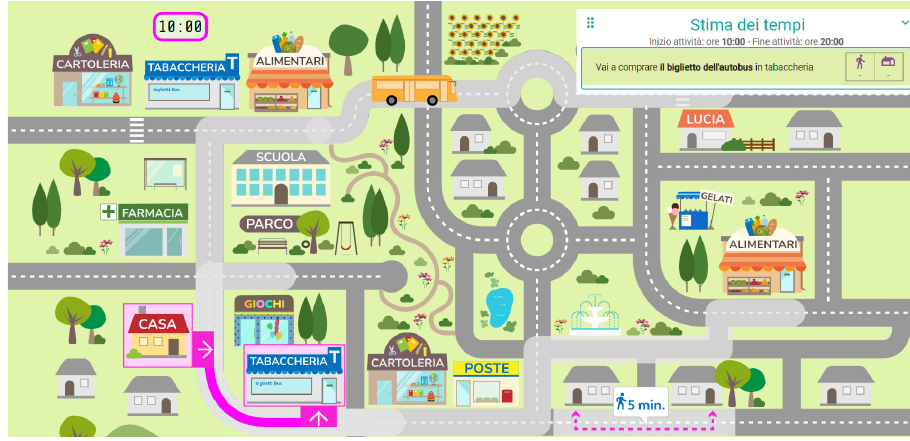
Figure 4. DPT map.